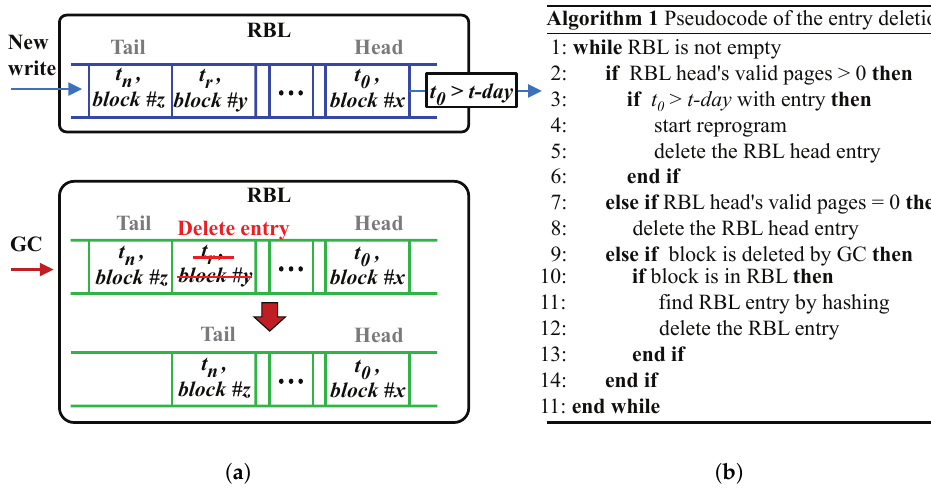
Algorithm 1 Pseudocode of the entry deletion